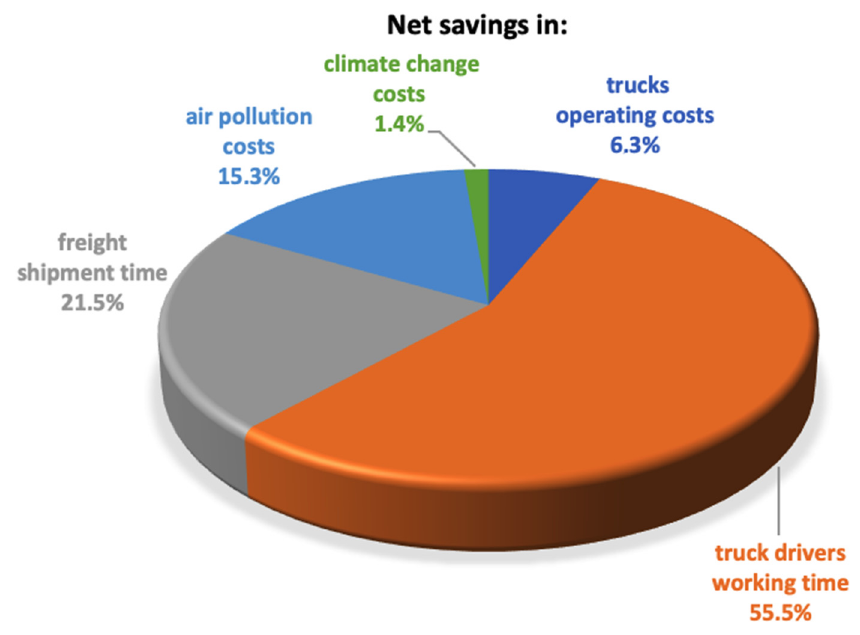
Figure 6. Structure of sustainable gains resulting from the reconstruction of the urban-port local road system. Source: own